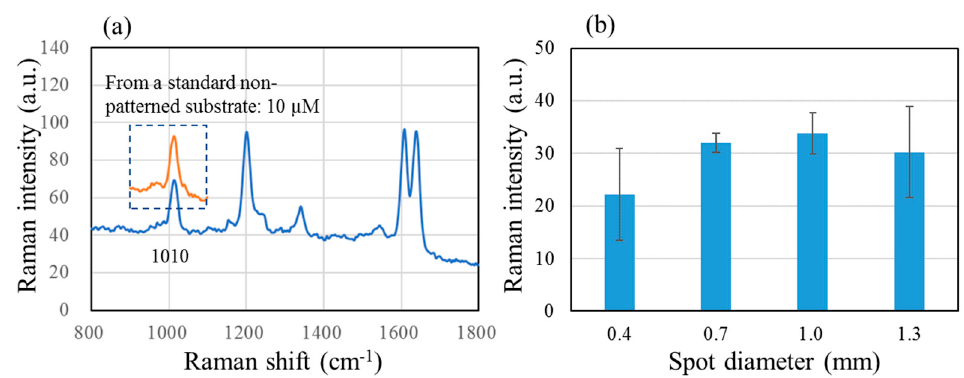
Figure 3. ( a ) SERS spectrum of 0.01 µM 1,2-bis(4-pyridyl) ethylene (BPE) obtained after pre- concentration on the patterned SERS substrate with 0.7 mm spot, superimposed with the 1010 cm − 1 peak for 10 µM BPE obtained with a standard non-patterned substrate and ( b ) a bar graph of the 1010 cm − 1 peak intensity with spot diameters of 0.4, 0.7, 1.0 and 1.3